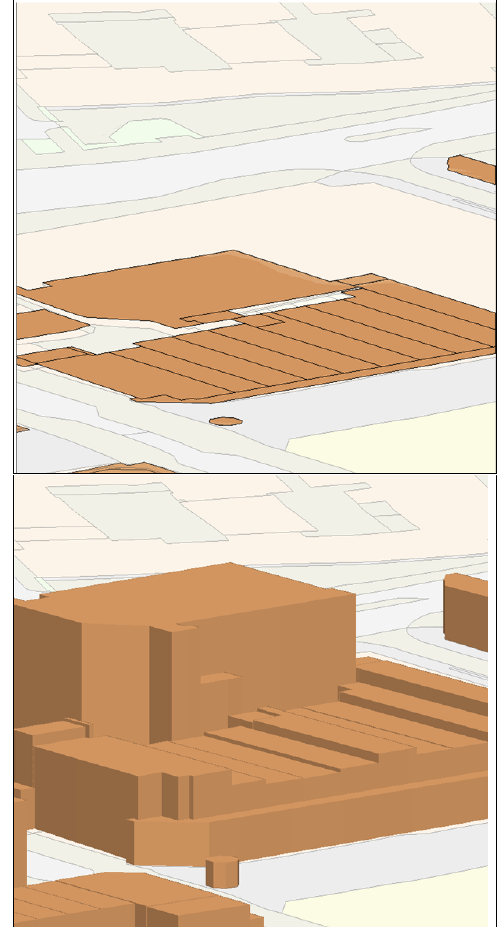
Figure 13: An extract of the Sheffield Dataset showing that Inter- nal Walls are also